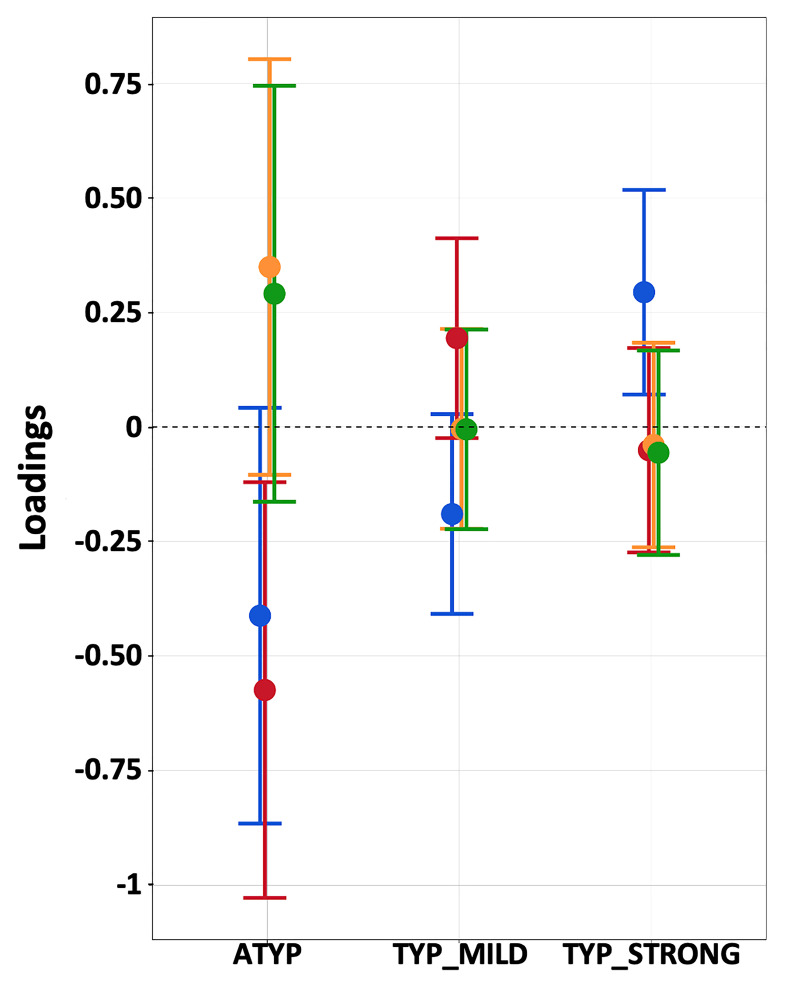
Estimated loadings of the four main principal components of cognitive abilities in the three groups having different language lateralization.The color code for the components is as follows: SPA: blue, MEM: red, PHONO: light orange, and VERB: green. Error bars represent 95% confidence intervals.Figure 5—source data 1.Data source for Figure 5.Figure 5—source data 2.Detailed information concerning the Figure 5 data source file.